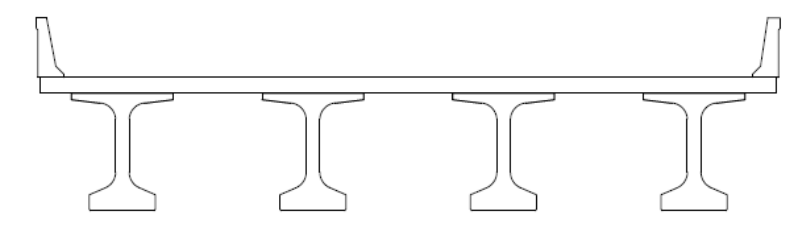
Figure 1. Typical bridge cross section used in Wisconsin.